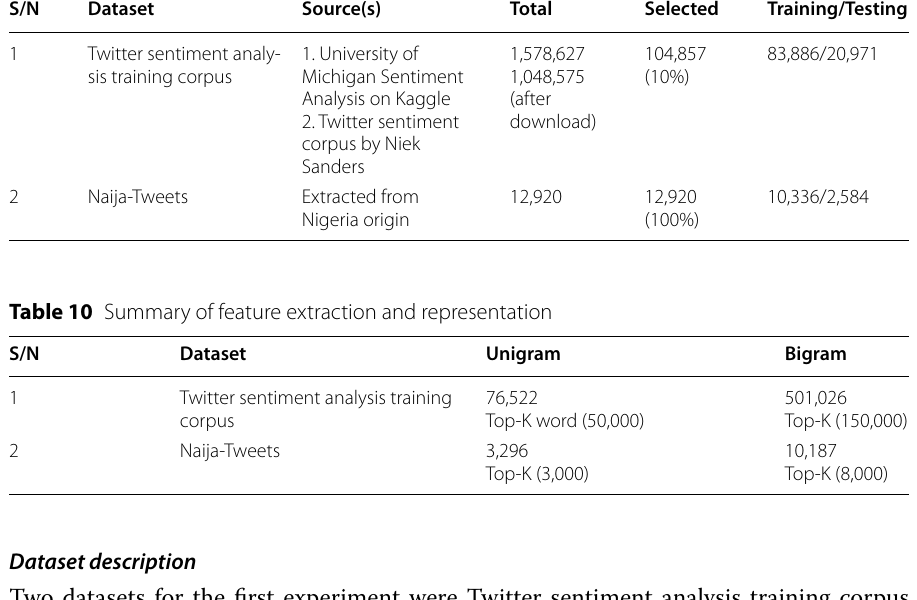
Table 9 Summary of twitter sentiment analysis training corpus and Naija-tweet dataset S/N